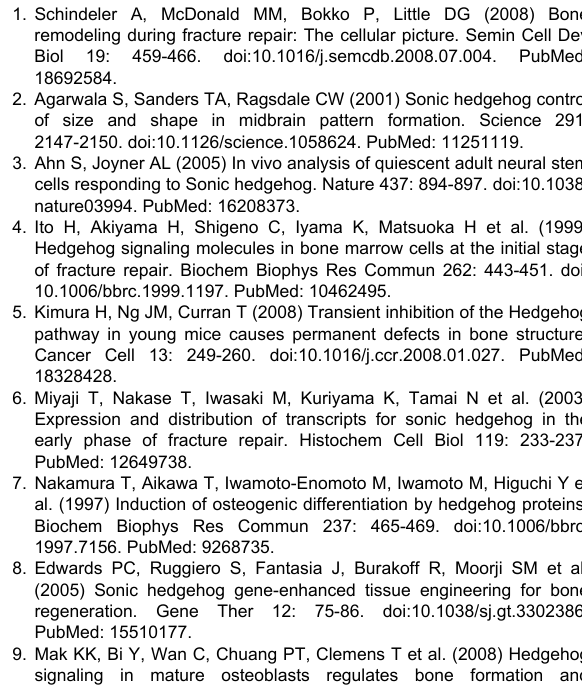
Figure S1. Immunofluorescence staining for osteopontin (green); pFAKTyr 397 (red) and 4’6’–diamino-2-phenylindole staining (blue) in the fractured site on day 5. Dotted line indicate the bone surface at the fracture site.